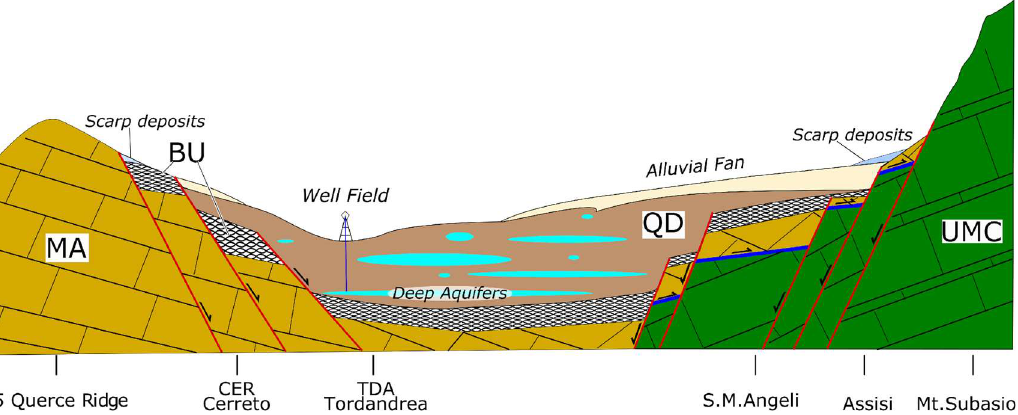
Figure 8. Schematic and out-of-scale geological profile along the A-A’ trace (mod. [47]): (MA) Marnoso Arenacea Formation; (UMC) North Appeninic carbonate multilayer; (BU) Bevagna unit; (QD) Quaternary deposits.